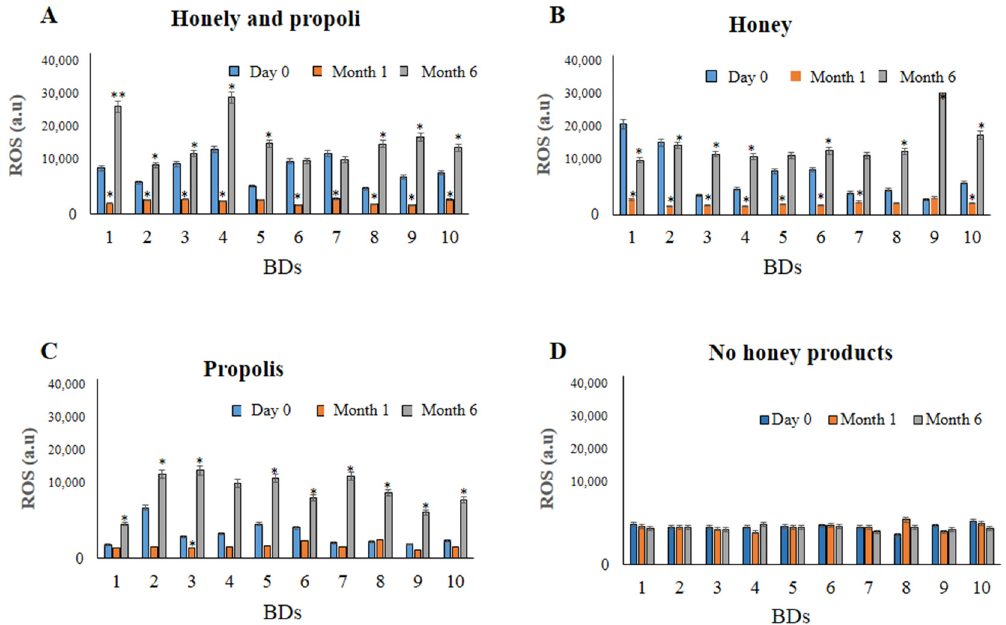
Figure 2. ROS levels (a.u) of selected blood donors ( n = 10). ( A ) Group A, Greek honey and propolis; ( B ) group B, honey;( C ) group C, propolis; and ( D ) group D; no honey products intake Data are the averages ± SDs of the 5 measurements. Significant differences from day 0 are represented as * p <